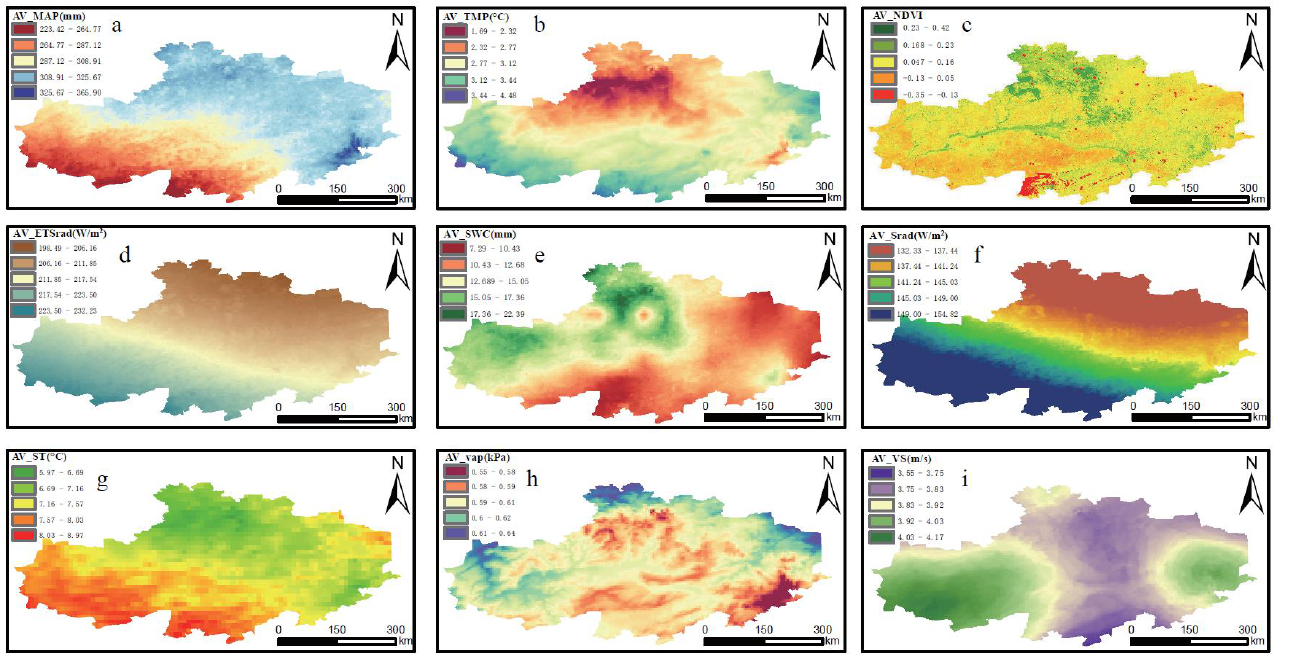
Figure 5. Spatial distribution of environmental factors in Akmola State: ( a ) average annual precipitation; ( b ) average annual temperature; ( c ) NDVI; ( d ) potential solar radiation; ( e ) soil water content; ( f ) solar radiation values; ( g ) soil temperature; ( h ) vapor pressure values; and ( i ) wind speed.